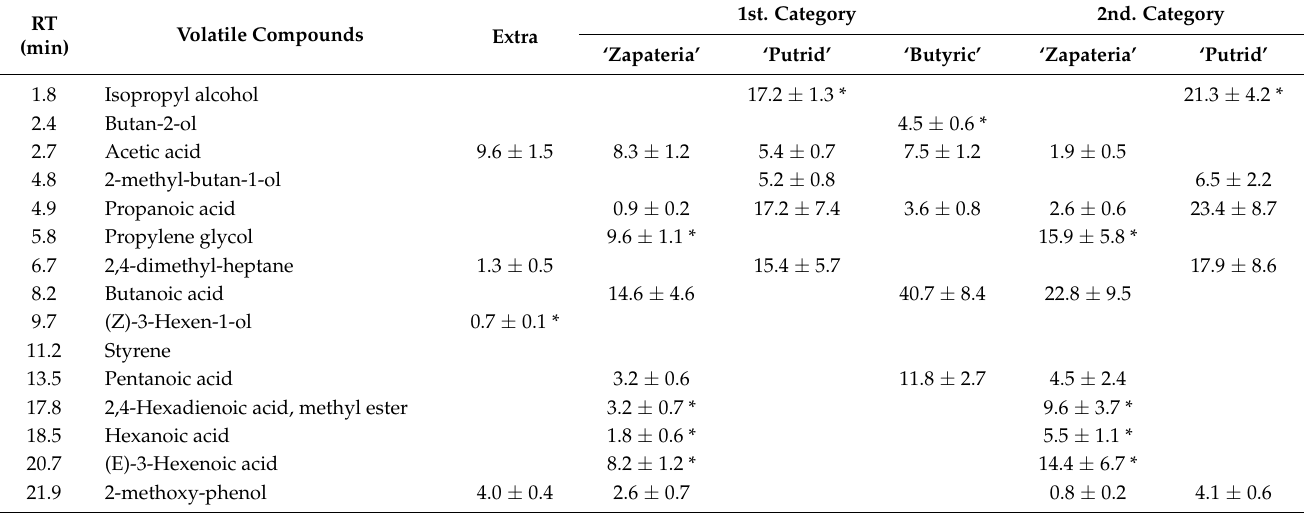
Table 2. Relative percentage of volatile compounds obtained from altered Spanish-style table olives classified into different commercial categories. RT, retention